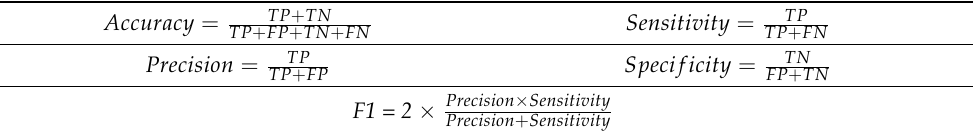
Table 2. Model evaluation parameters.